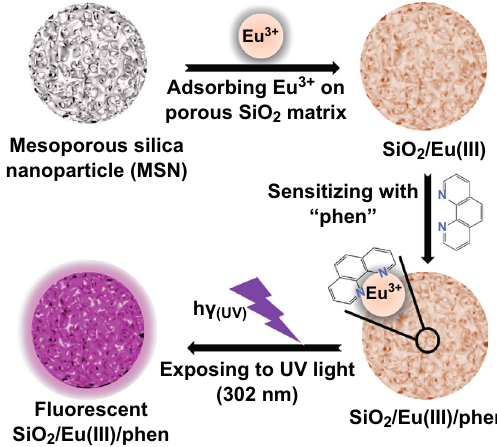
Fig. 1 Schematic illustration of the major steps of the protocol for sensitive detection of Eu 3 ? ions from diluted solutions relying on the synergy of ‘‘concentration effect’’ and ‘‘antenna